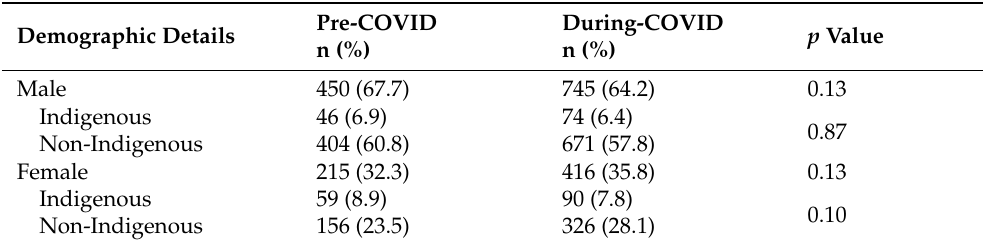
Table A1. Proportional changes in ED admissions among patients with SUD stratified by gender and Indigenous status before and during COVID-19.